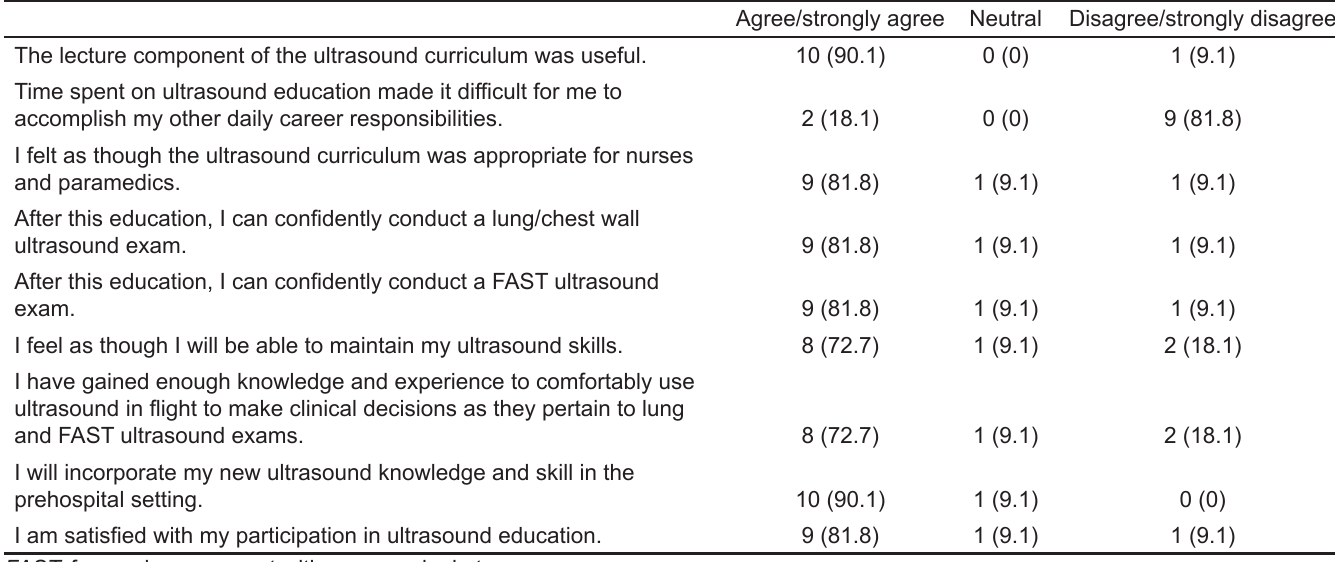
Agree/strongly agree Neutral Disagree/strongly disagree